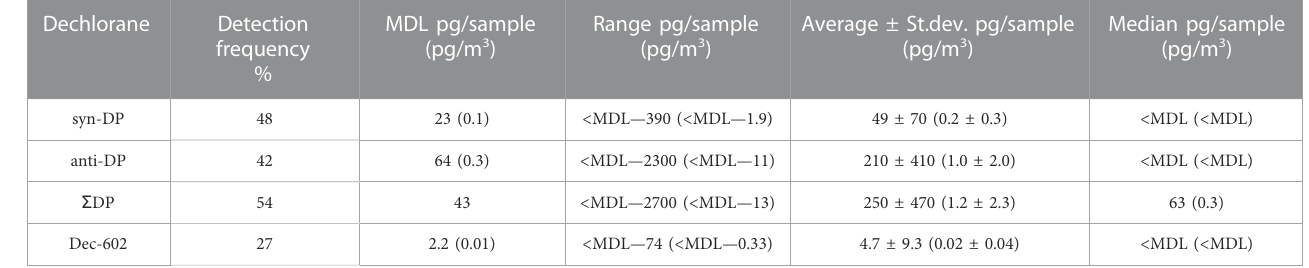
TABLE 1 Detection frequency (%), method detection limit (MDL), range, average ± standard deviations (St.dev.) and median for the atmospheric concentrations of Dechlorane Plus syn- and anti-isomers, Ʃ DP (the sum of syn-DP and anti-DP), and Dec-602, at 97 sites across Europe. The results are given in mass per sample (pg/ sample) and in mass per volume (pg/m 3 ) in brackets (derived from a sampling rate of 2.3 m 3